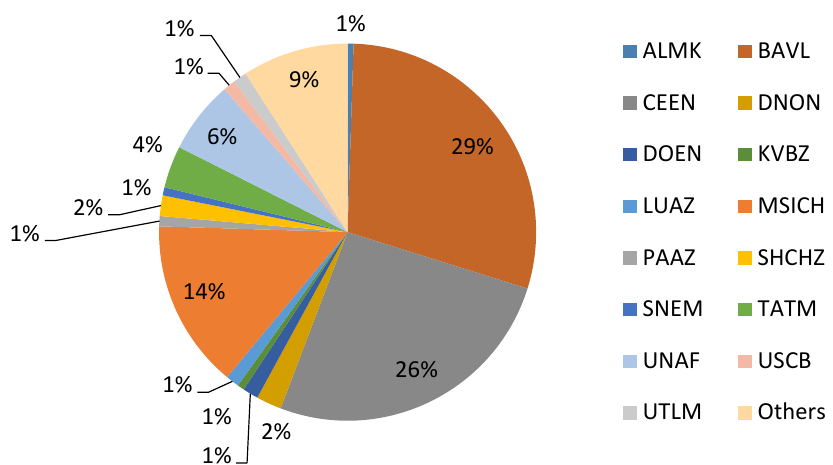
Figure 3. Structure of trades in the Ukrainian Stock Exchange: case of issuers in 2017